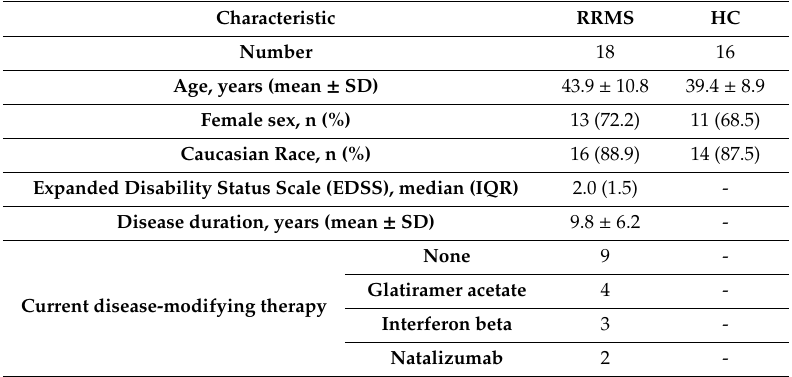
Table 1. Demographic and disease characteristics of